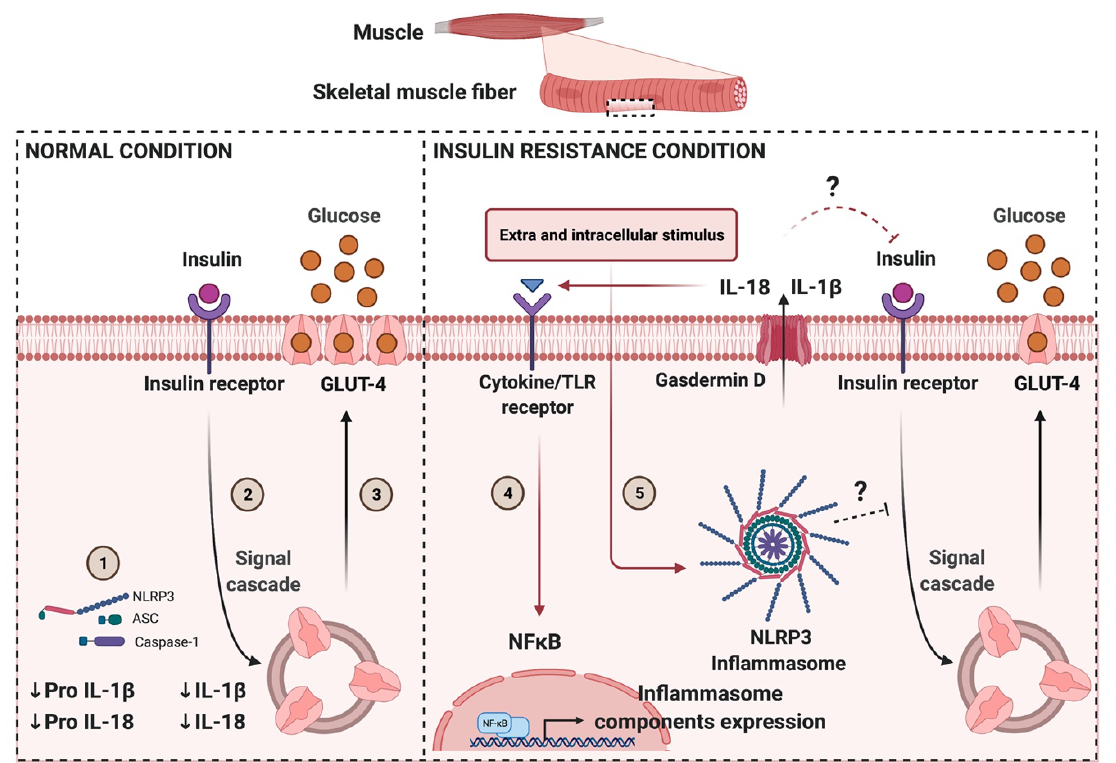
Figure 4. Schematic figure showing NLRP3 inflammasome activation and its possible modulation on insulin-mediated signaling in skeletal muscle during normal and insulin resistance conditions. In normal conditions, the expression of the NLRP3 inflammasome components is low, suggesting that the priming signal is inhibited. Consequently, there is a decreased expression and processing of pro-interleukins (1). In response to insulin (2), the GLUT4 transporters translocate to the sarcolemma and T-tubule system, promoting glucose transport (3). During IR conditions, an increased priming signal promotes the NF- κ B mediated expression of the NLRP3 inflammasome components, plus their assembly and activation. Several extracellular and intracellular stimuli may play a role in NLRP3 inflammasome activation, highlighting the importance of free fatty acids (FFA), ionic flux, extracellular ATP (eATP) and ROS, among others, which could lead to the proteolytic activation of the pro-inflammatory cytokines IL-1 β and IL-18 and its Gasdermins D (GSDMD)-mediated secretion (4,5). Excessive or prolonged NLRP3-dependent pro-inflammatory cytokine exposure may cause IR in skeletal muscle